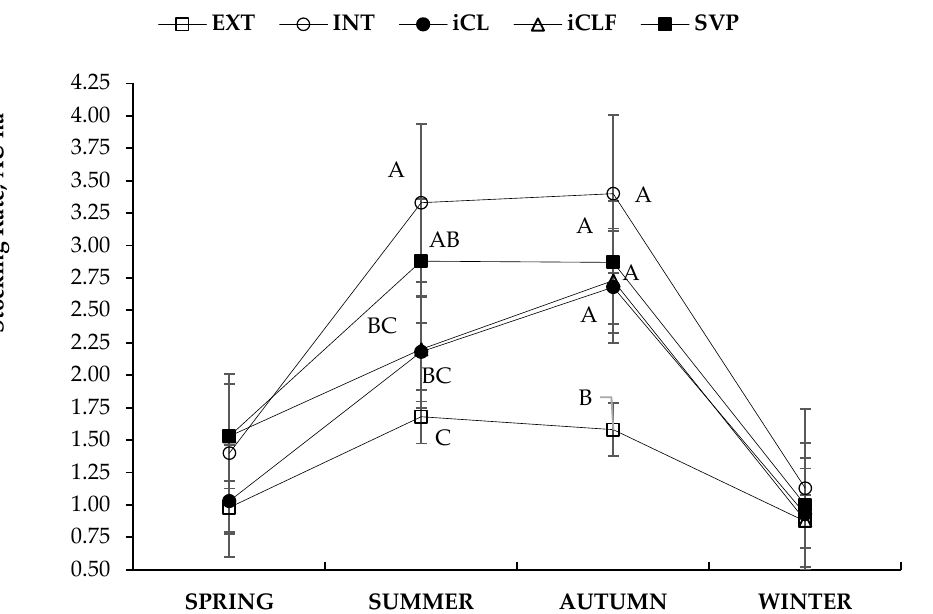
Figure A6. Stocking rate (AU ha − 1 ) during seasons from different livestock production systems (means of two years). Different letters in the same season differ from each other ( p < 0.05) according to the Tukey test. EXT: extensive; INT: intensive; iCL: integrated crop–livestock; iCLF: integrated crop–livestock–forest; iLF: integrated livestock–forest.